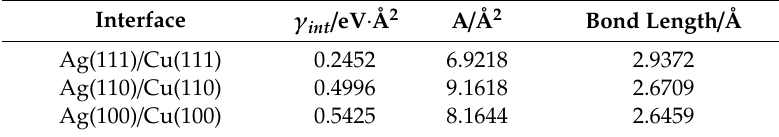
Table 2. The work of adhesion and interface energy at the Ag / Cu interface.